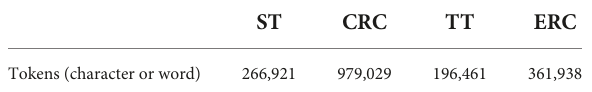
TABLE 1 Size of texts and